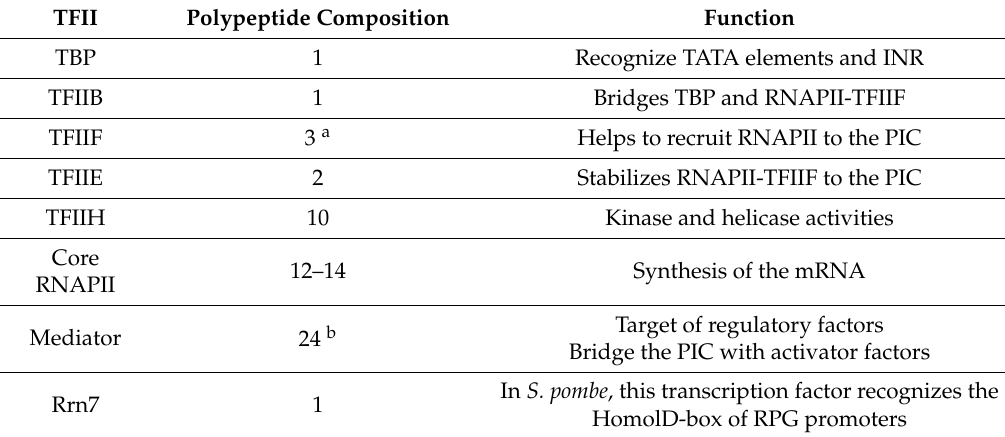
Table 1. RNAPII, TFIIs (GTFs) and